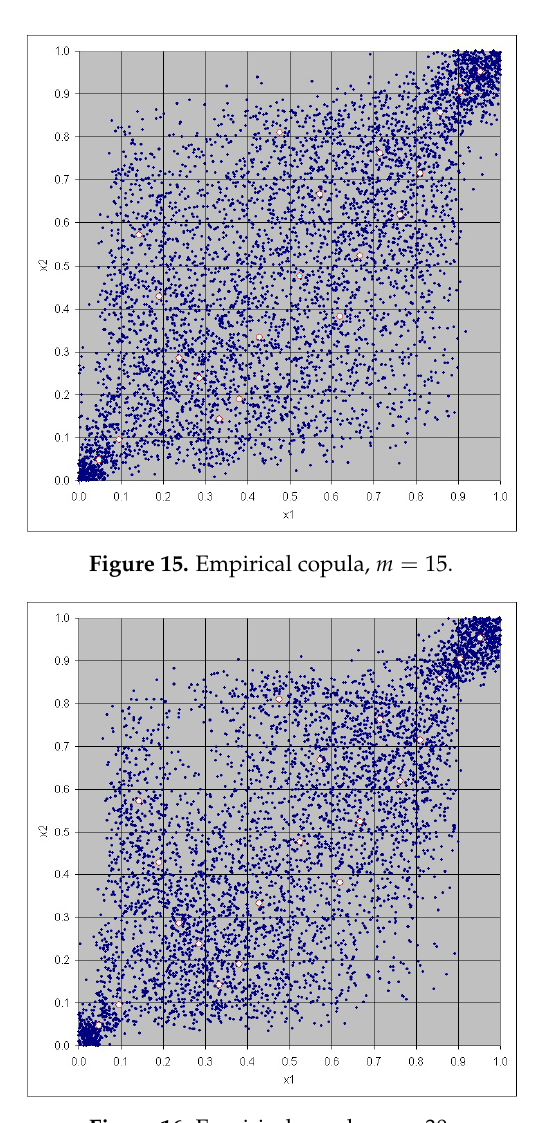
Figure 16. Empirical copula, m = 30.